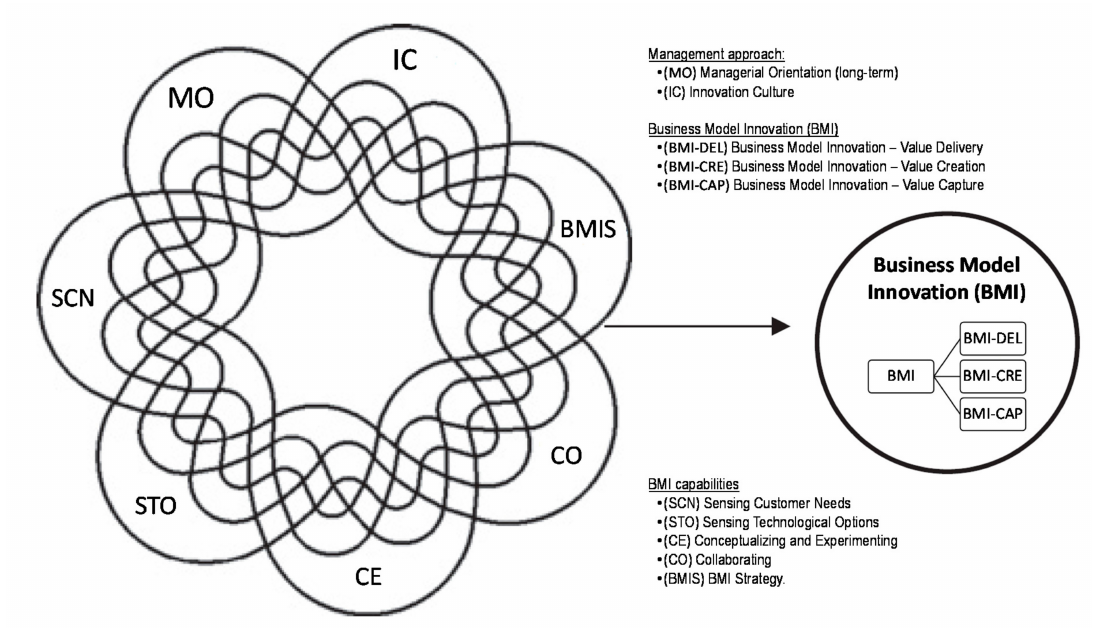
Figure 1. Research